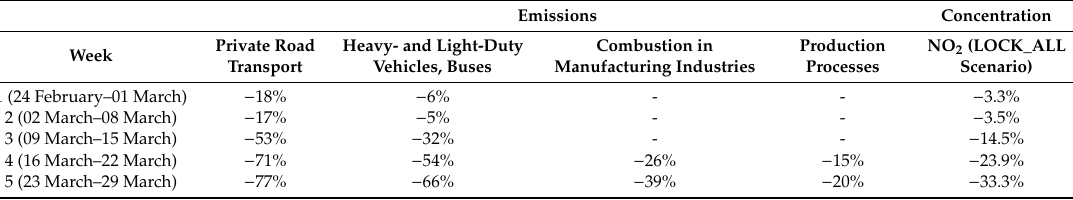
Table 2. Weekly average emission reduction coe ffi cients for the city of Milan and corresponding NO 2 average weekly concentration reduction estimated by the LOCK_ALL scenario.